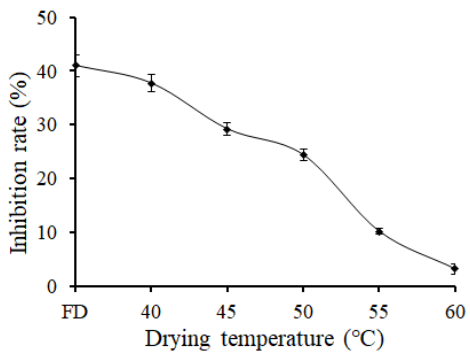
Figure 2. Effect of garlic powder drying temperatures on the inhibition rate of acrylamide in Glc/Asn solution system.